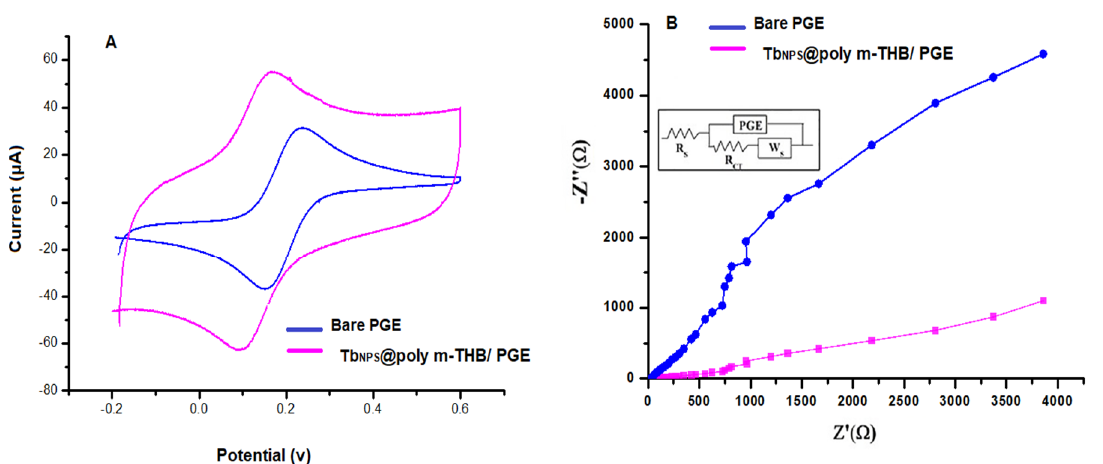
Figure 4. ( A ) Cyclic voltammograms and ( B ) Nyquist plot of 1.0 mM of Fe 3+ /Fe 2+ solution recorded on bare PGE and Tb NPS @ poly m-THB/PGE electrodes. Working parameters are: scan rate 50 mV s −1 over a potential range of −0.2–0.6 V.